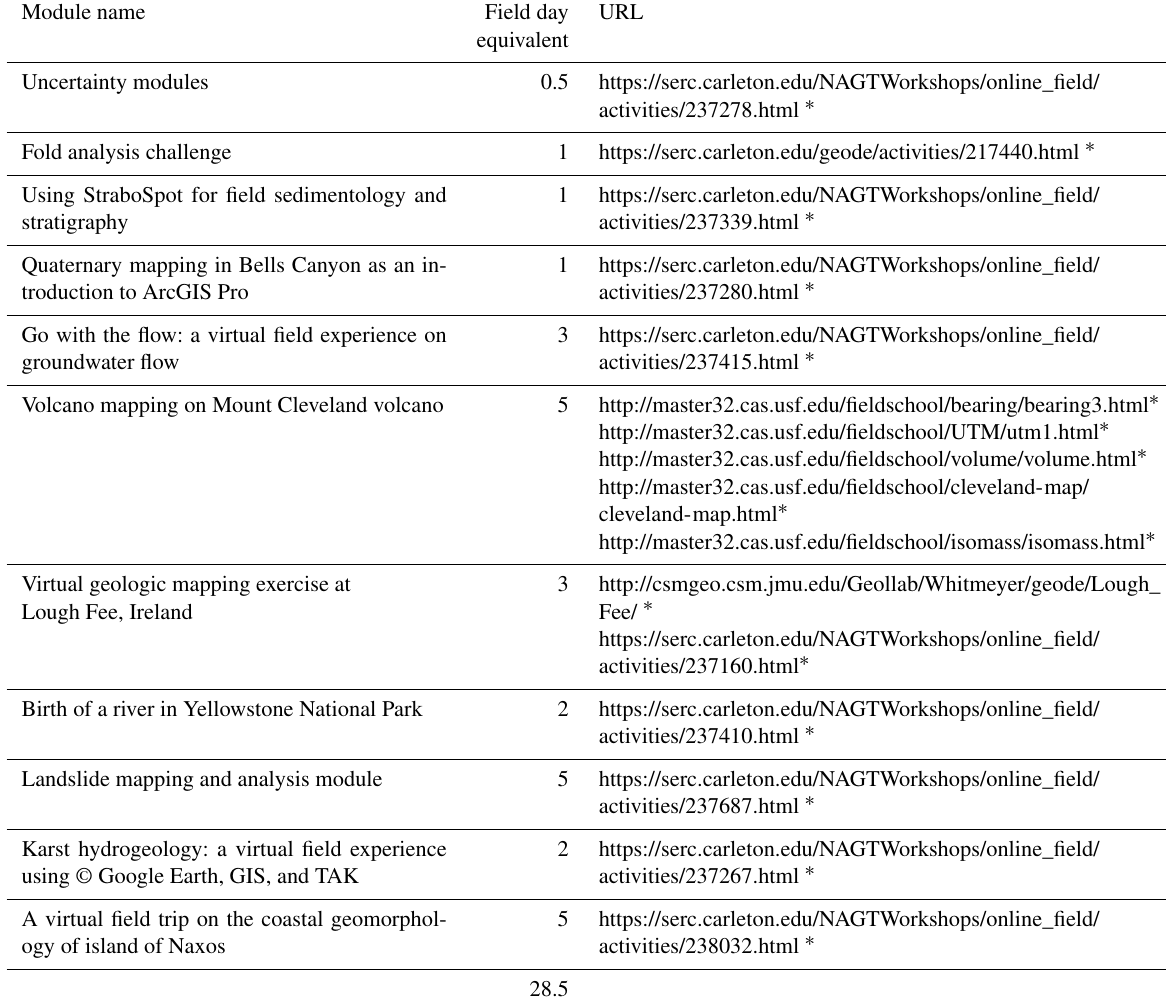
Table 4. Modules for environmental geology virtual capstone